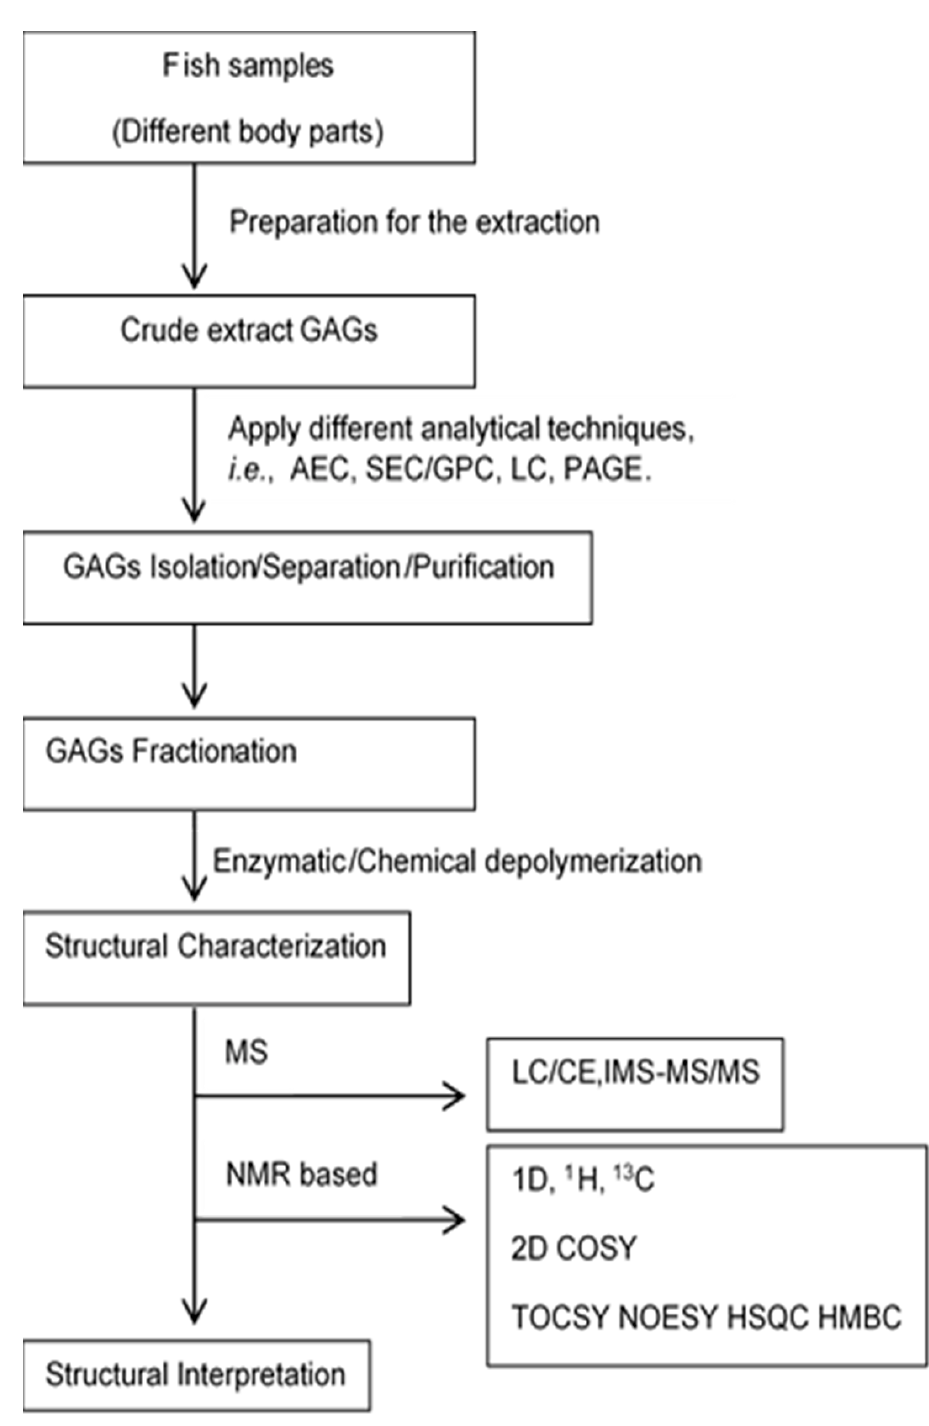
Figure 3. A common schematic presentation of different GAGs analysis. A specific enzyme (i.e., papain, alcalase, trypsin) or chemical solvent (i.e., chloroform, acetate, sodium acetate, chloroform- amyl alcohol) was used to produce